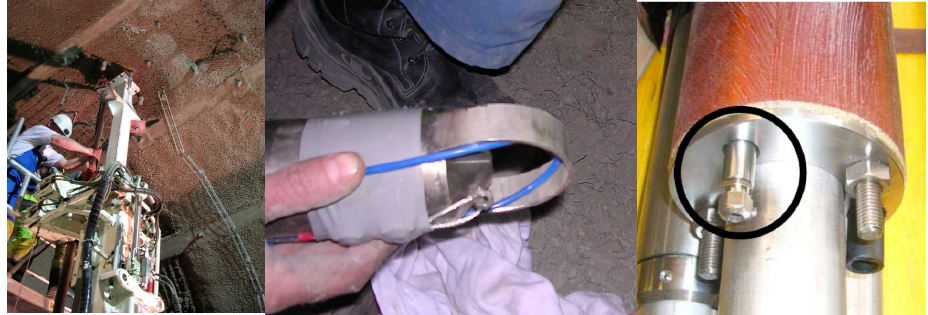
Figure 14. Pictures of distributed temperature system implementation inside vertical borehole ( left ). Example for a curvature guide ( middle ) and connector ( right ) to get the sensing cable through packers.